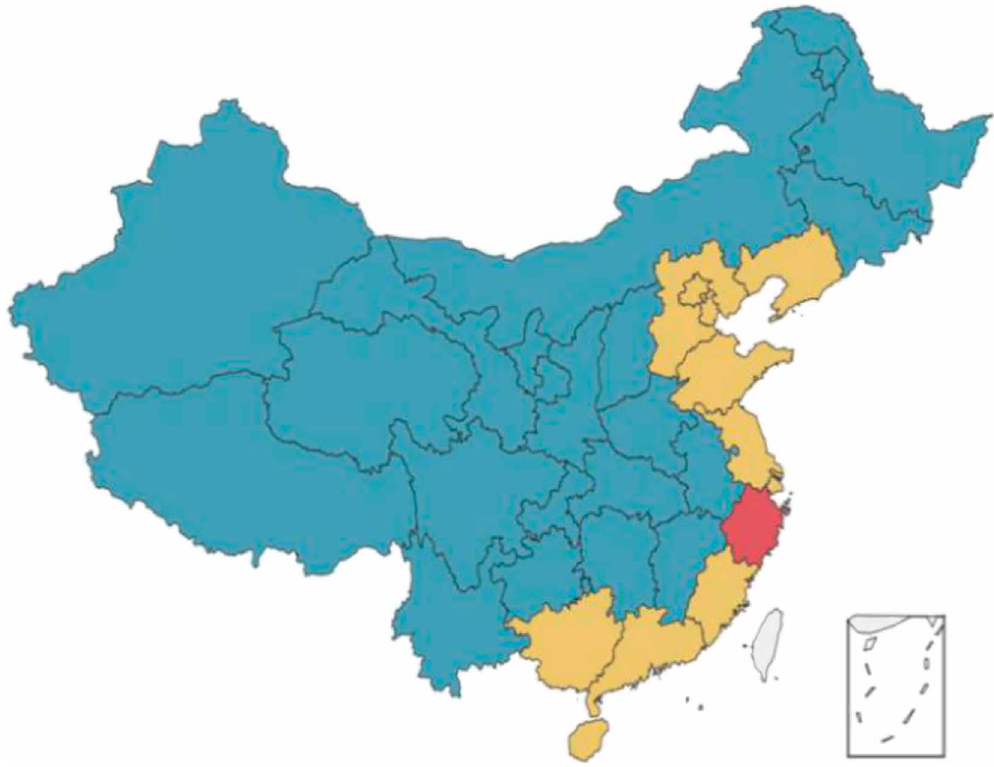
Figure 1: Control group